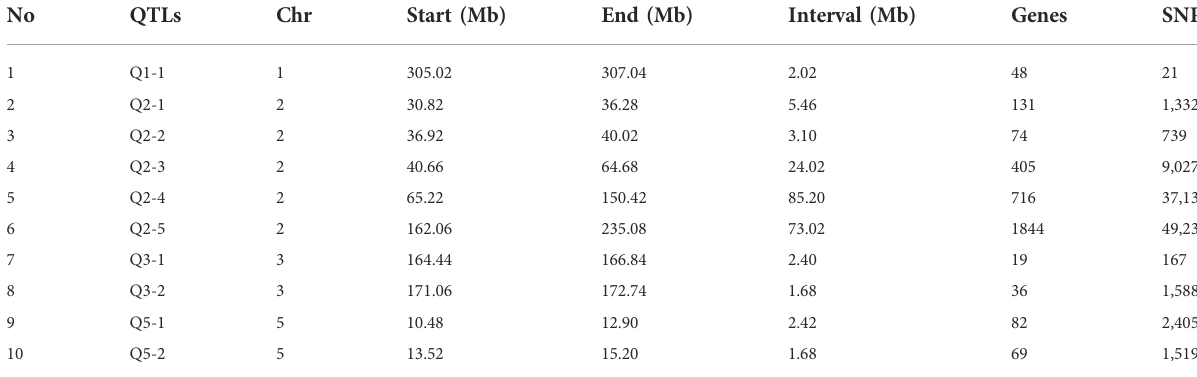
TABLE 1 Statistics for QTLs identi fi ed with a 99% con fi dence